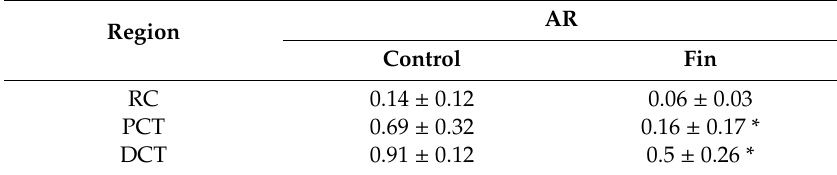
Table 2. The percentage of AR-positive cells in the renal corpuscle (RC), the proximal convoluted tubule (PCT), and the distal convoluted tubule (DCT) of control and finasteride-treated (Fin) rats. AR Region